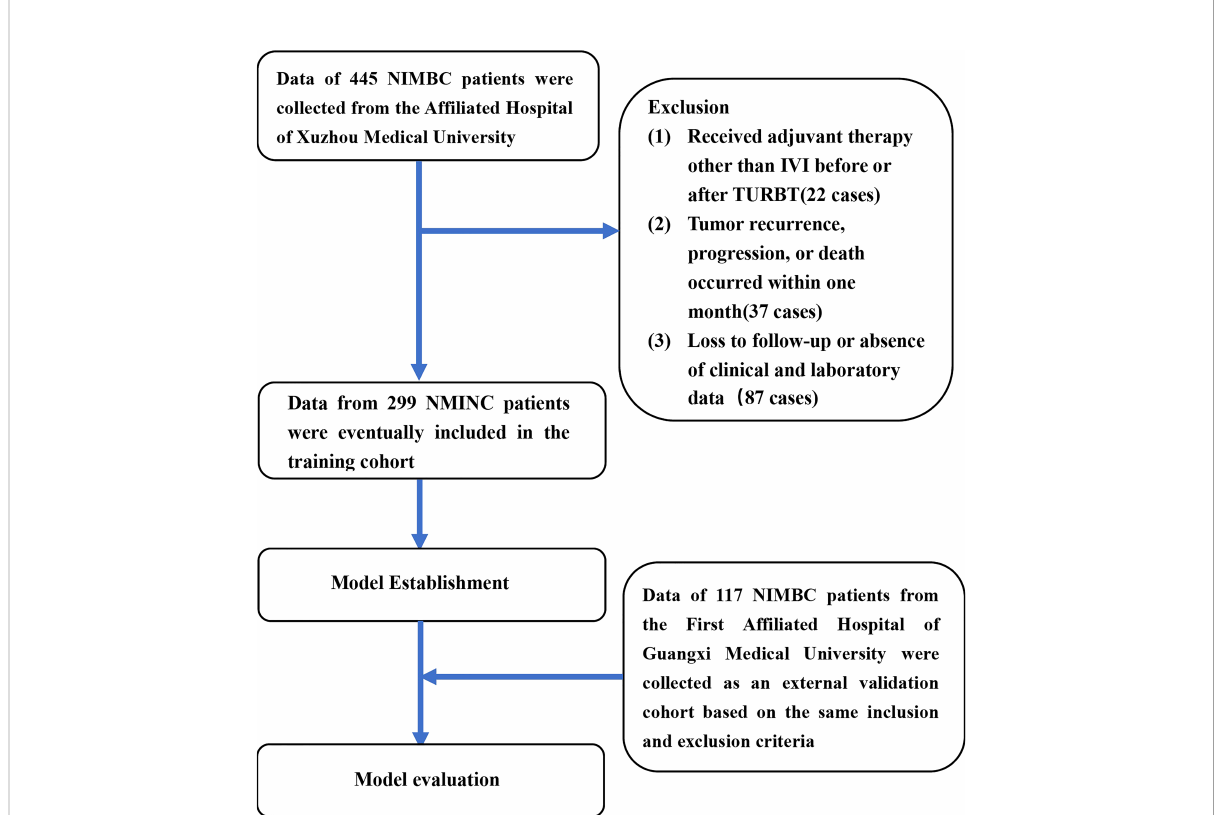
FIGURE 1 The fl ow chart for study inclusion and exclusion in the training cohort and external validation cohort. NMIBC, non-muscle-invasive bladder cancer; IVI, intravesical instillation; TURBT, transurethral resection of the bladder